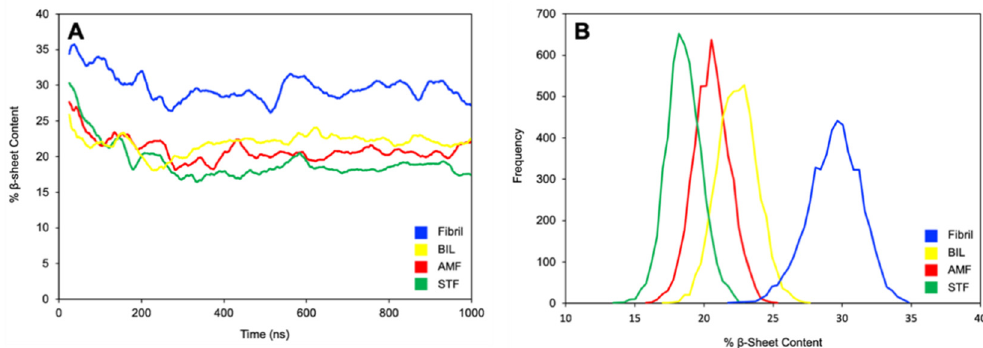
Figure 8. Results from secondary structure analysis on the molecular dynamic (MD) simulations. Simulations were performed with A β 42 alone (Fibril) or in the presence of bilobetin (BIL), amentoflavone (AMF), and sotetsuflavone (STF). ( A ) Change in % β -sheet content over time for the MD trajectories averaged every 25 ns. Ligand-bound simulation shows greater β -sheet content relative to the ligand-free simulation. Note that all simulations started at the same % β -sheet content (~35%), but due to the moving average calculation, the first 25 ns were not able to be captured graphically resulting in apparent varying starting points. ( B ) Histogram showing the β -sheet conformations sampled over the last 500 ns of the MD trajectories. The ligand-free simulation shows greater β -sheet content relative to the ligand-bound simulations. For visual clarity, we have only included the data for four simulations here; secondary structure data for all simulations can be found in the Supporting Information.